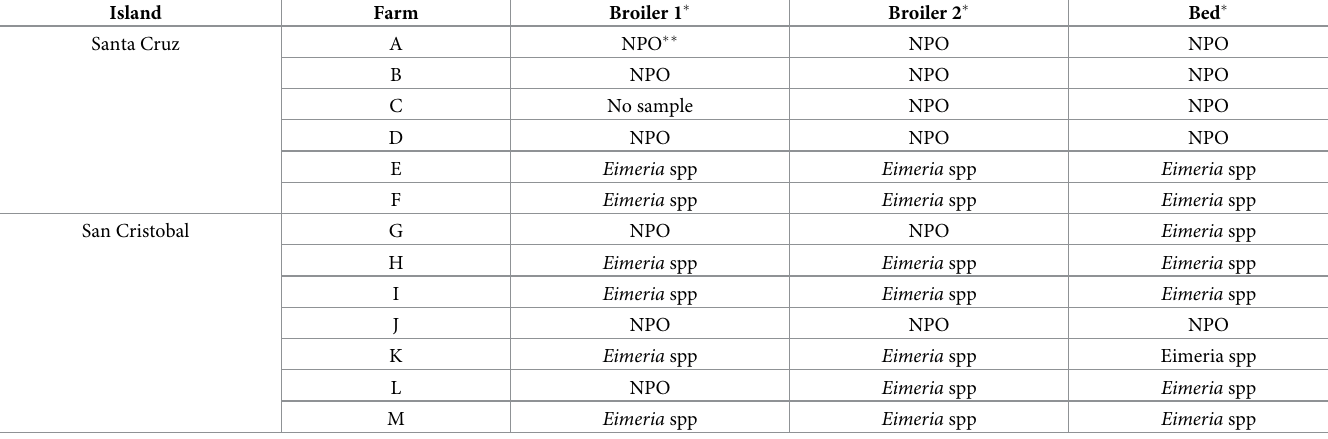
(cid:3) On each study farm, fecal samples from two harvested broilers and one environmental (pen bedding) sample were collected and examined for diagnosis of intestinal parasites. (cid:3)(cid:3) NPO = No parasites observed.